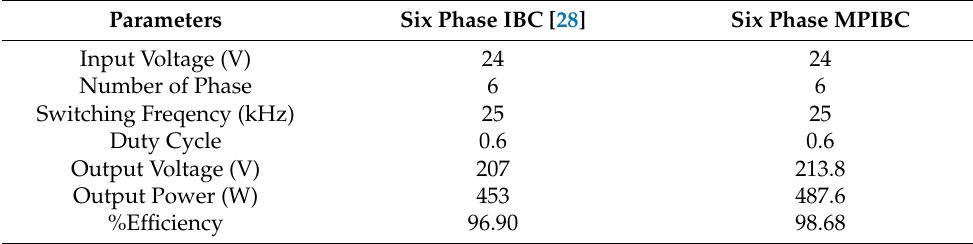
Table 10. Six phase MPIBC comparison with existing